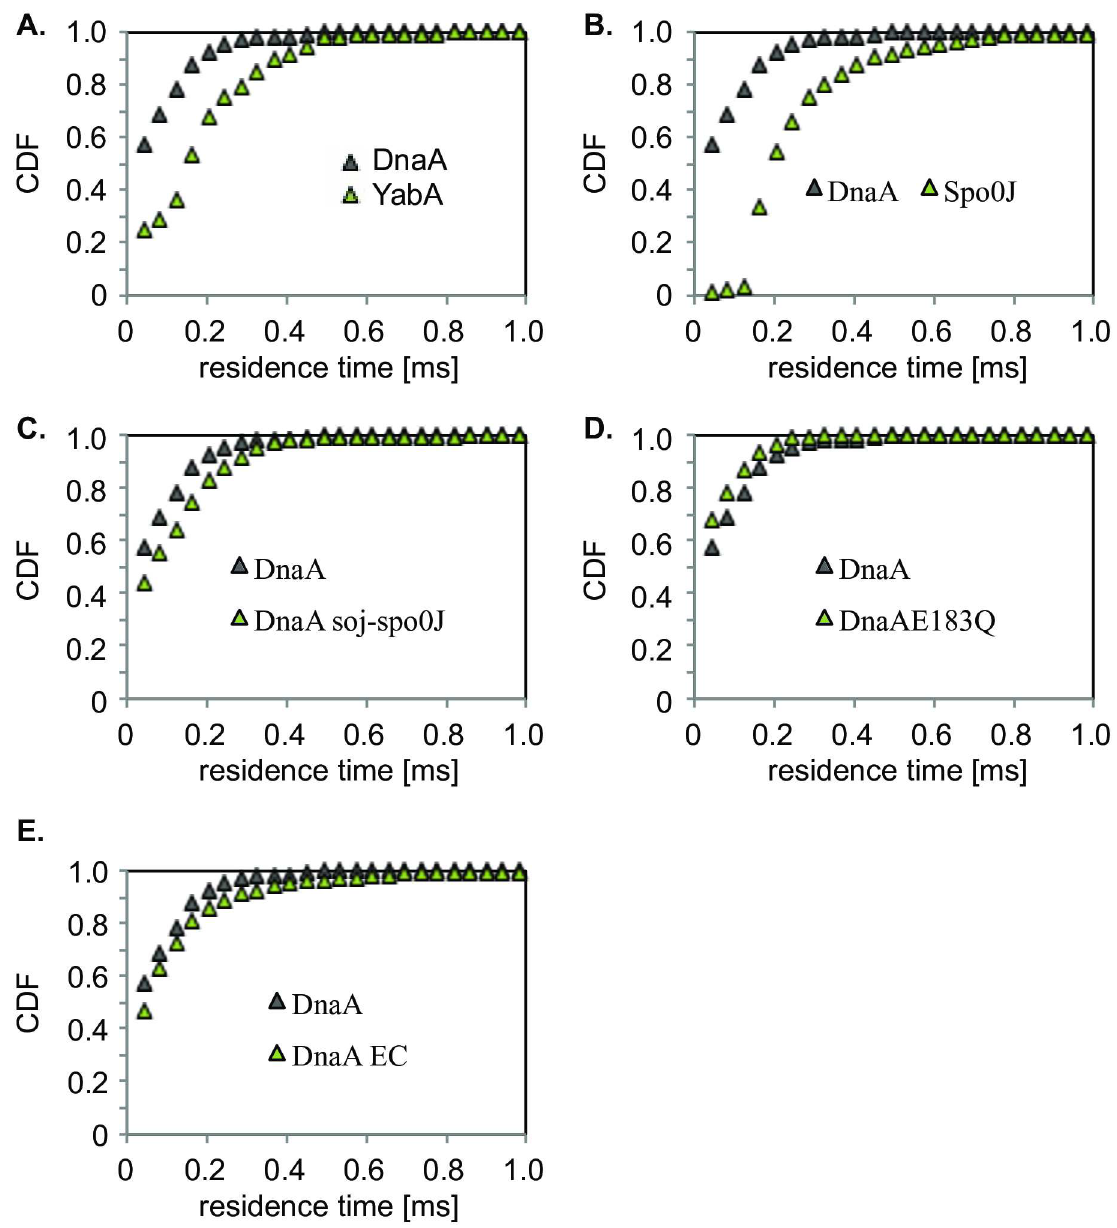
Fig 7. Cumulative distribution functions (CDF) of residence times. The plots show the cumulativeprobabilitythat a moleculeremains in a circle of radius 230 nm for the indicatedtime. A) Comparisonof YFP-DnaA expressedfrom the ectopic amyE locus under the control of a xylose induciblepromoter(ME15) and YFP-YabA expressedfrom the ectopic amyE locus under the control of a xylose inducible promoter in a strain deletedfor YabA. B) Comparison of ME15 and YFP-Spo0J expressed from the ectopic amyE locus under the control of a xylose induciblepromoter C) Comparisonof ME15 and YFP-DnaA expressed from the ectopic amyE locus under the control of a xylose induciblepromoter in a strain lacking Soj-Spo0J. D) YFP-DnaA (ME15) comparedwith YFP-DnaAE183Qexpressedfrom the ectopic amyE locus under the control of a xylose induciblepromoter. E) YFP-DnaA (ME15) comparedwith E . coli DnaA-YFP sw expressedfrom the native locus. In all comparisons, the null hypothesis that the data of the curves come from the same distributions is rejectedat the 5% significance level (two-sampleKolmogorov- Smirnov (KS)